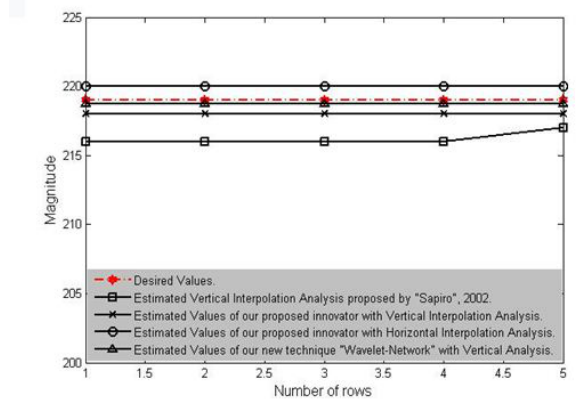
Fig. 12. The performance efficiency of the proposed wavelet-network